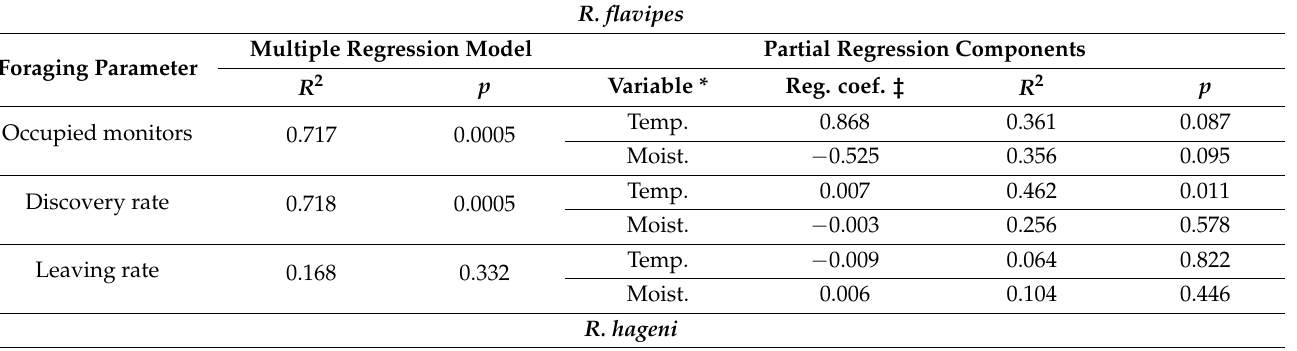
Table 3. Statistics of multiple linear regression for climatic factors (soil temperature and soil moisture) and foraging activity for Reticulitermes flavipes , R. hageni , and R. virginicus